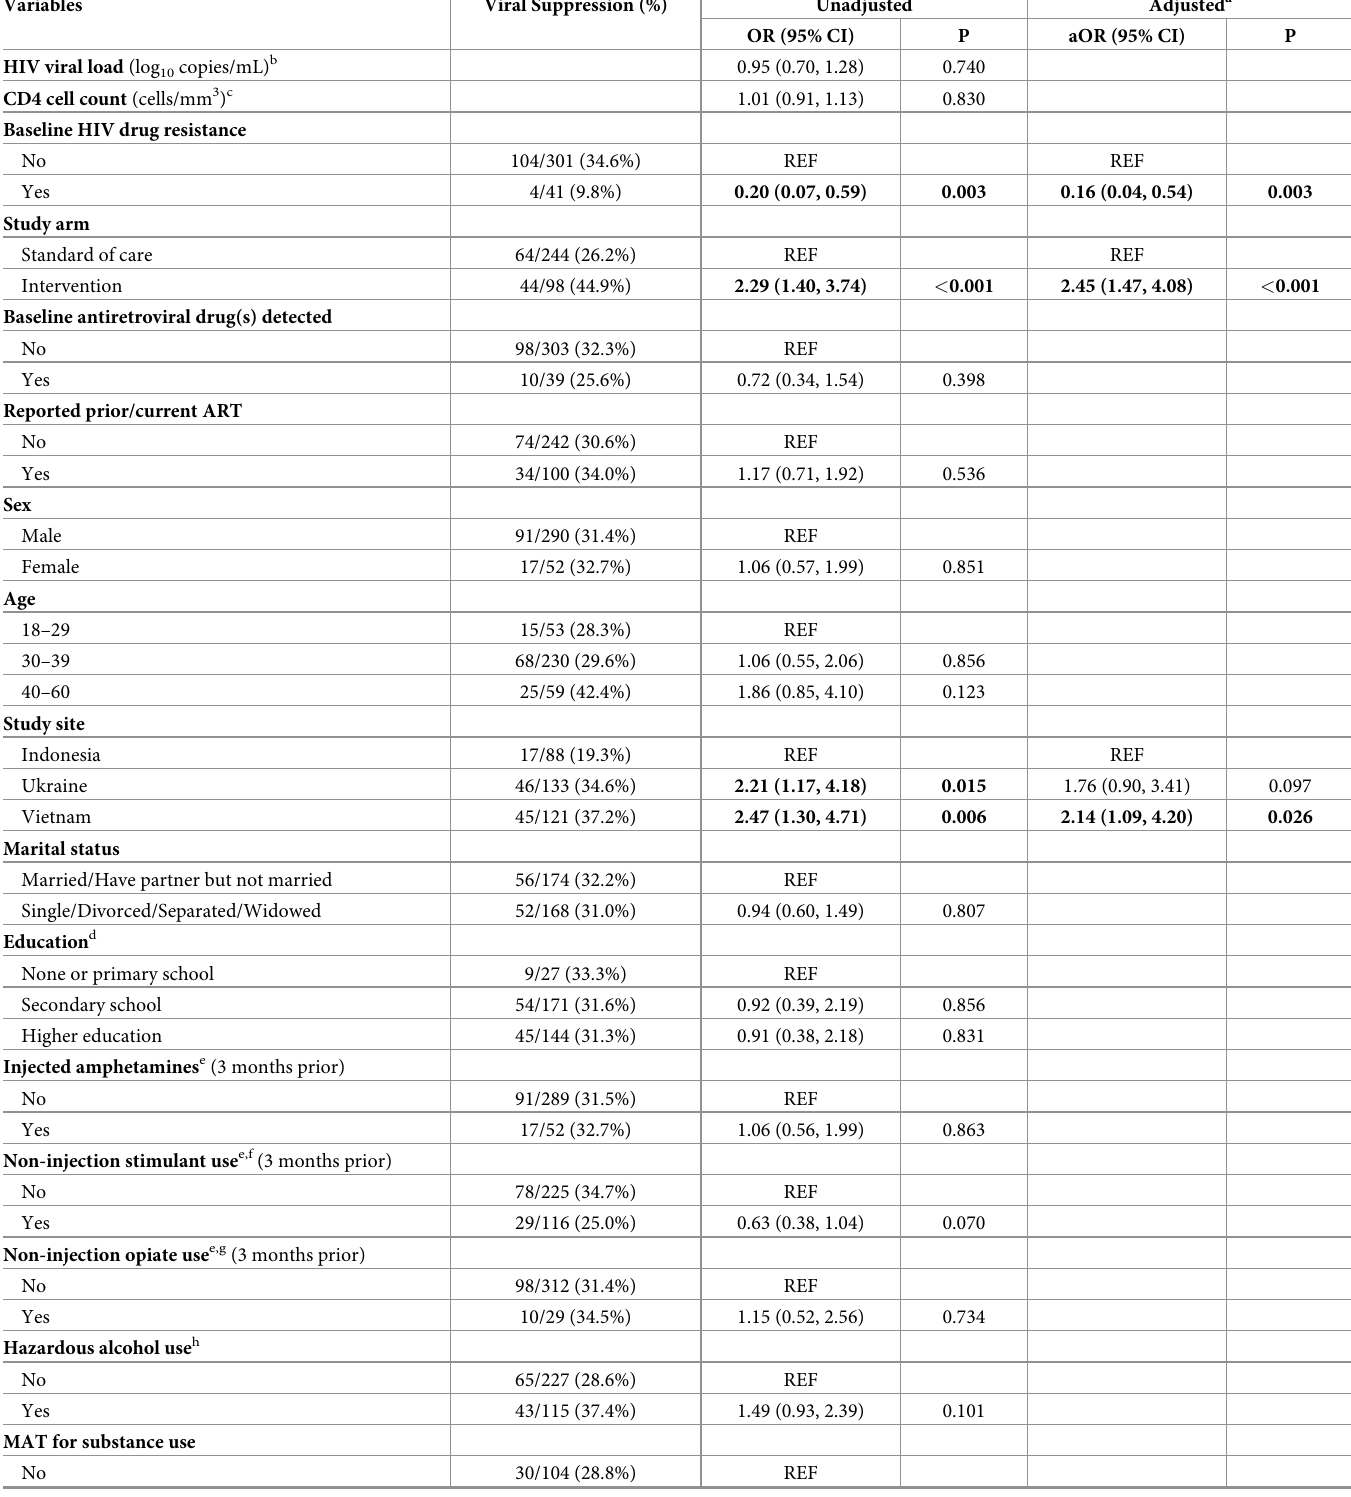
Table 4. Baseline factors associated with viral